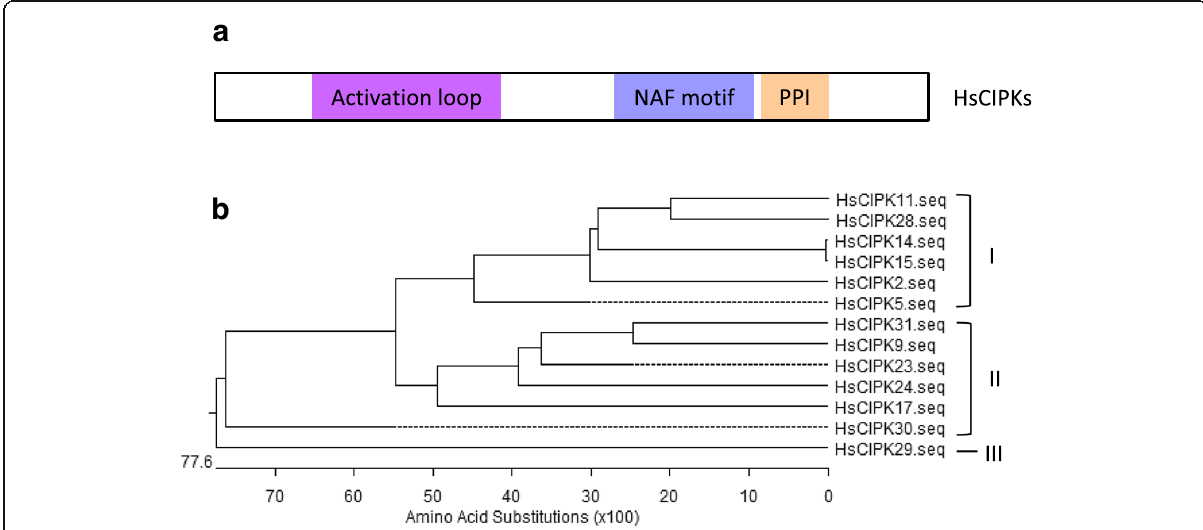
Fig. 1 Schematic diagram and sequence analysis of HsCIPKs. a Prediction of functional domains in HsCIPKs. b Phylogenetic analysis of 13